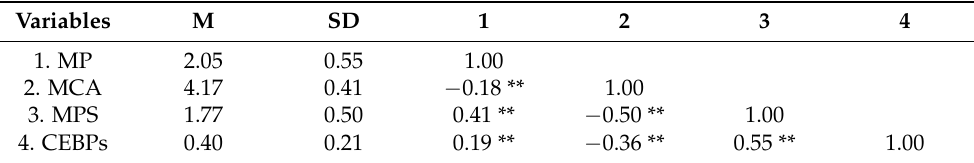
Table 1. Descriptive statistics and correlations amongst variables (N = 988).